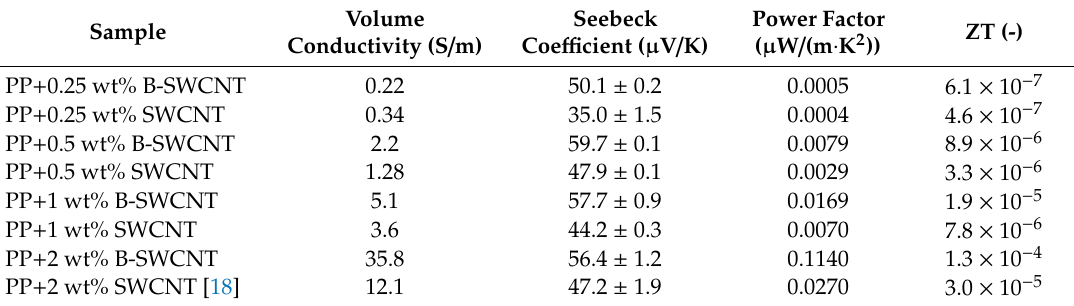
Table 1. Thermoelectric parameters for PP (grade 400R) filled with B-SWCNTs or SWCNTs.